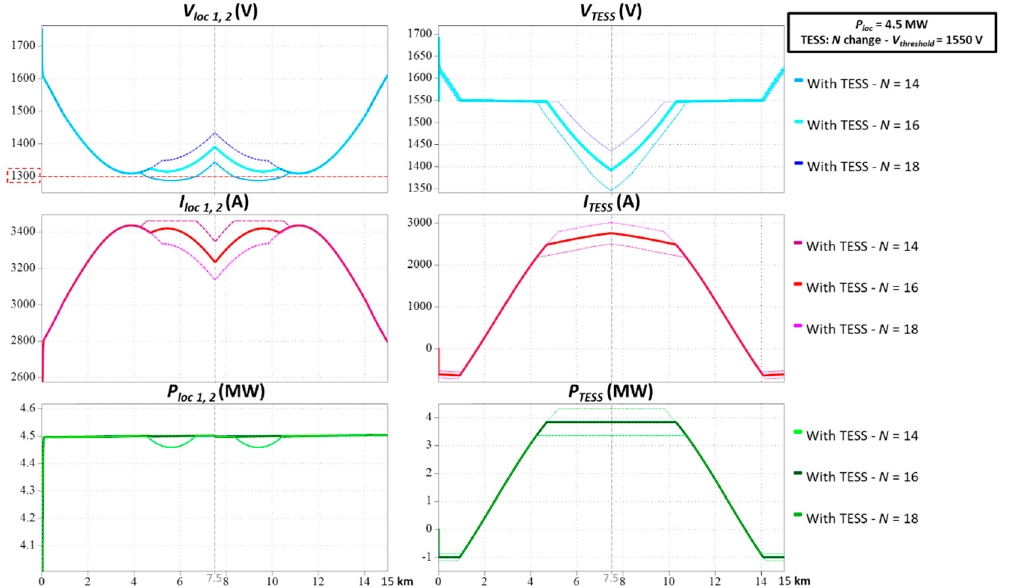
Figure 10. Simulation results according to the location of the crossing point of locomotives 1 and 2 in the sector. Analysis of the influence of N ( V threshold = 1550 V; P loc = 4.5 MW).